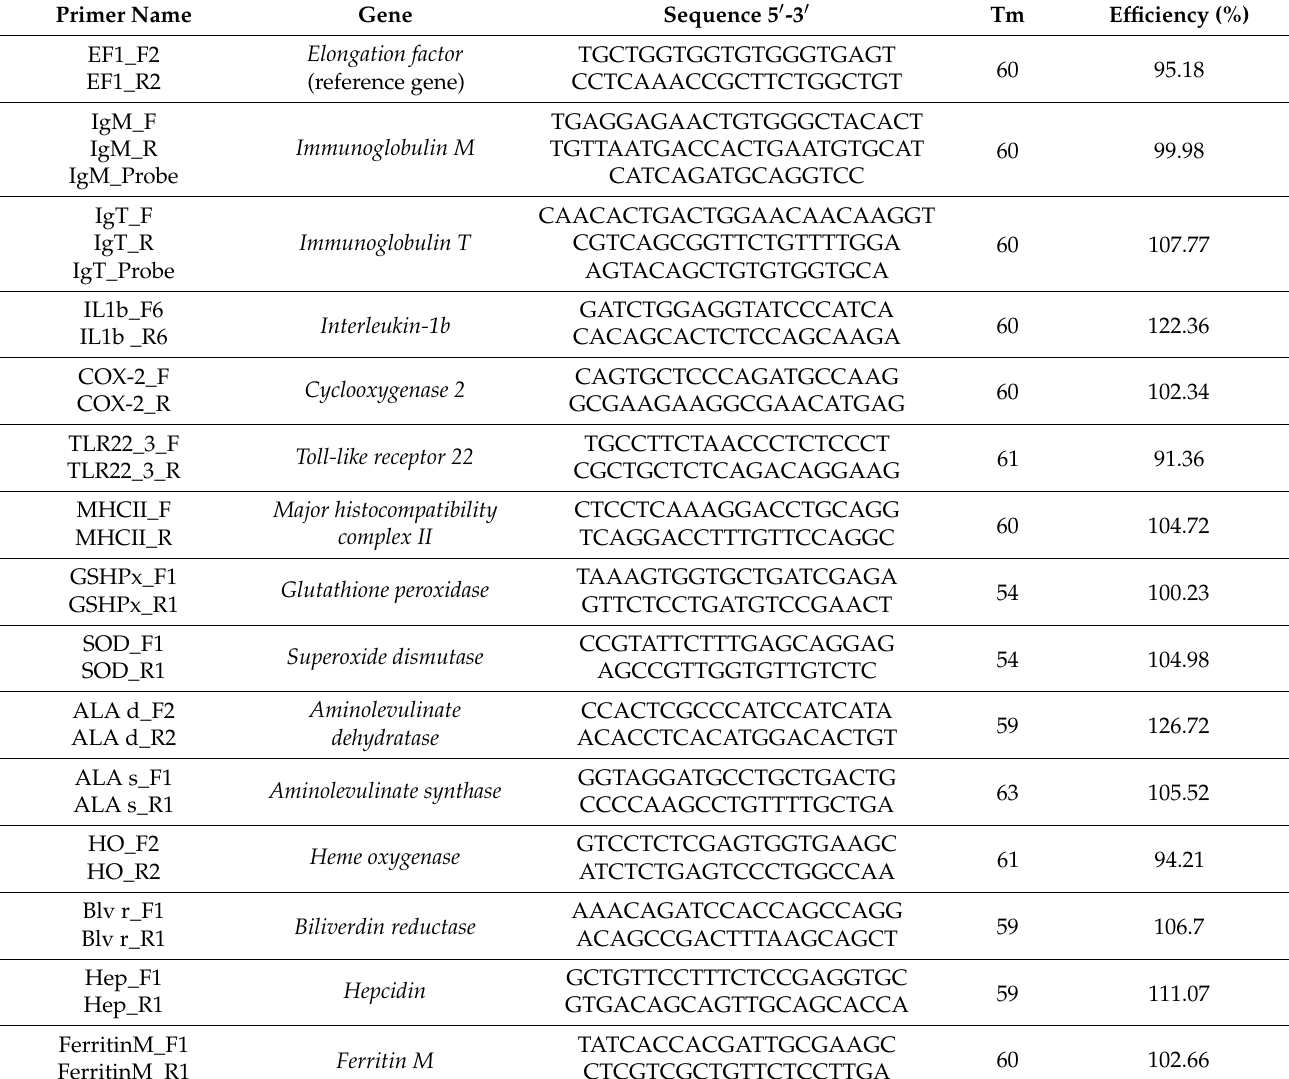
Table 1. Primer list used for RT-qPCR